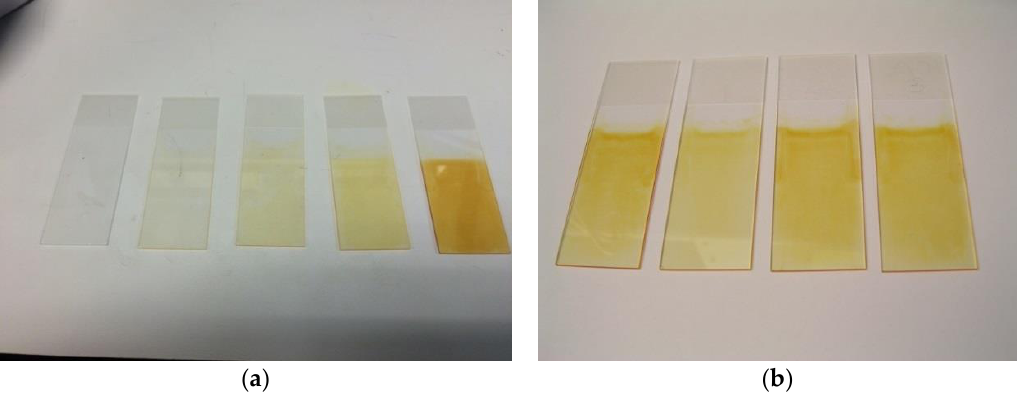
Figure 3. ISAM films display homogeneity. Left photo: blank slide and (PAH / DY) films with 2, 4, and 6 bilayers (from left to right). The final slide has 6 bilayers with an additional PAH cap that protects films at high pH levels. Right photo includes (PAH / DY) 6.5 films (from left to right) before thermal treatment, and after thermal treatment at 46.2, 3.3, and −13.7 °C.